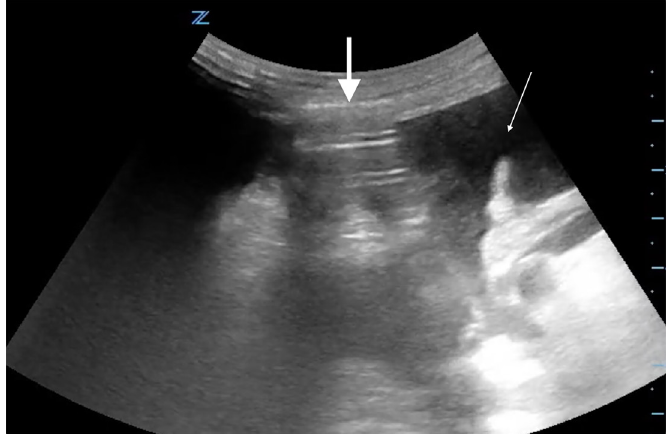
Image 1. Abdominal ultrasound from Case 1 showing free intra- peritoneal fluid (thin arrow) as well as free intraperitoneal air (thick arrow) as demonstrated by the enhanced peritoneal stripe sign and reverberation